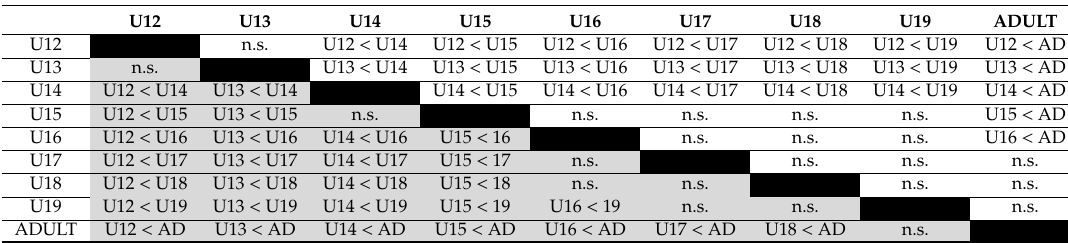
Table 2. Bonferroni post-hoc analysis of body height and body mass (white background, body height; grey background, body mass).